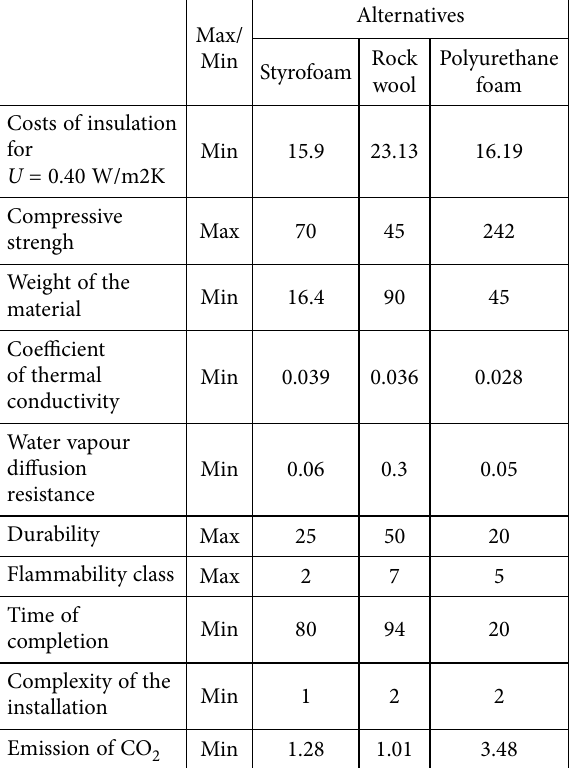
Table 3. Decision-making matrix Table 4. Normalised decision-making